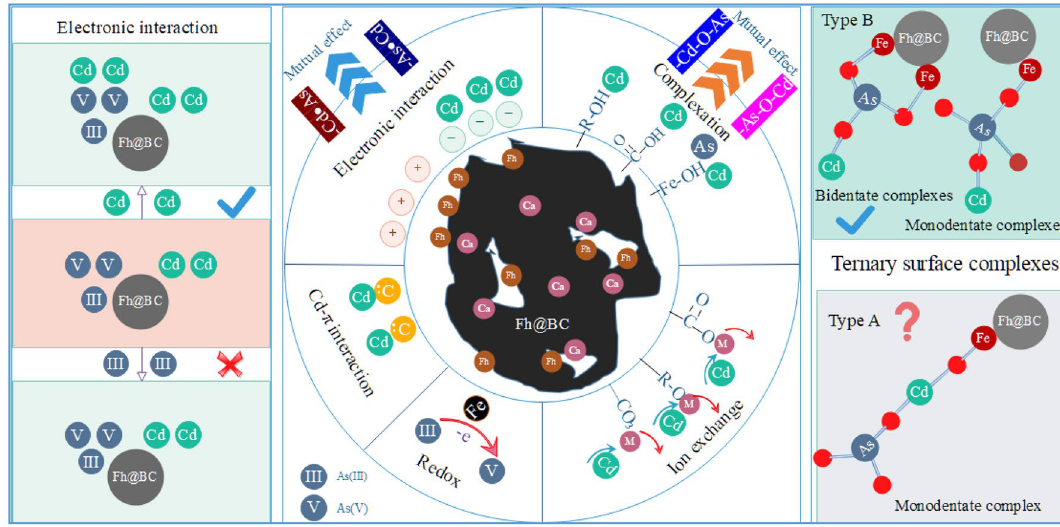
Figure 6. Schematic diagram of adsorption mechanism of Fh@BC for Cd(II) and